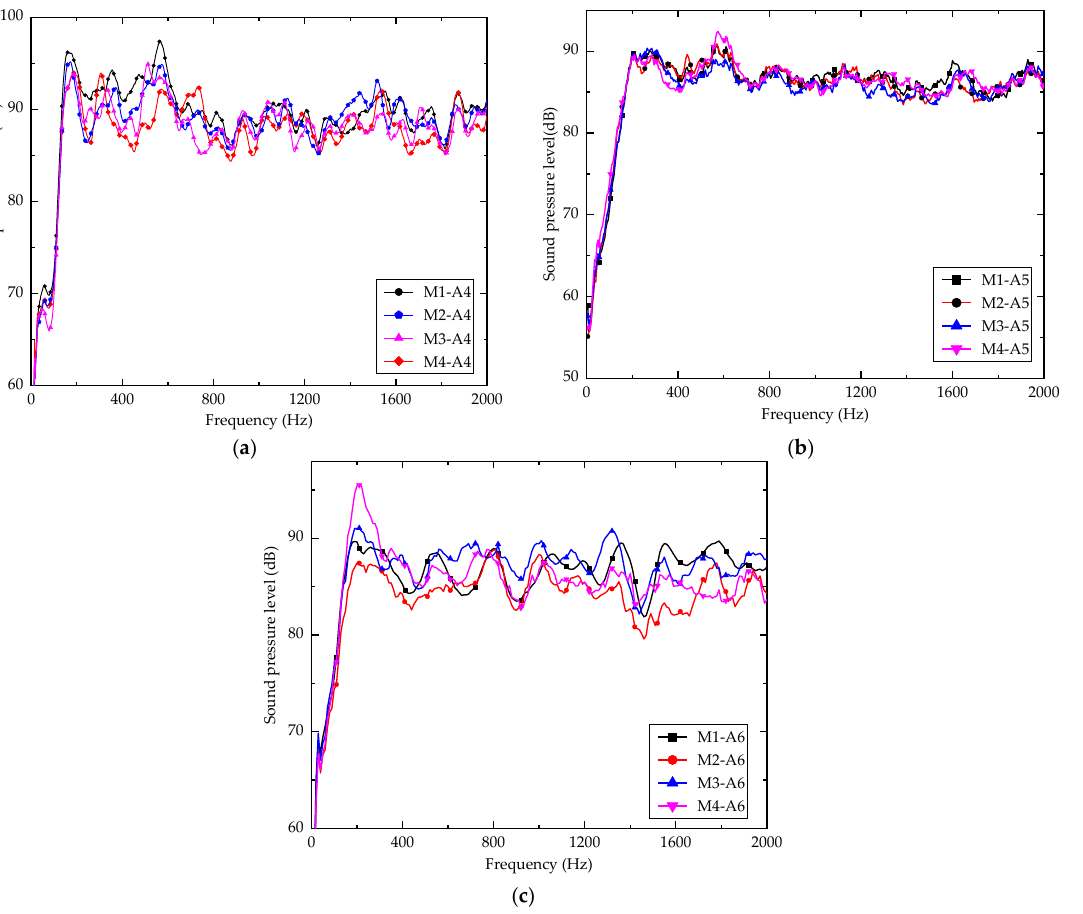
Figure 12. Comparison of sound pressure levels at different measuring points. ( a ) Measuring point A1; ( b ) measuring point A2; ( c ) measuring point A3.